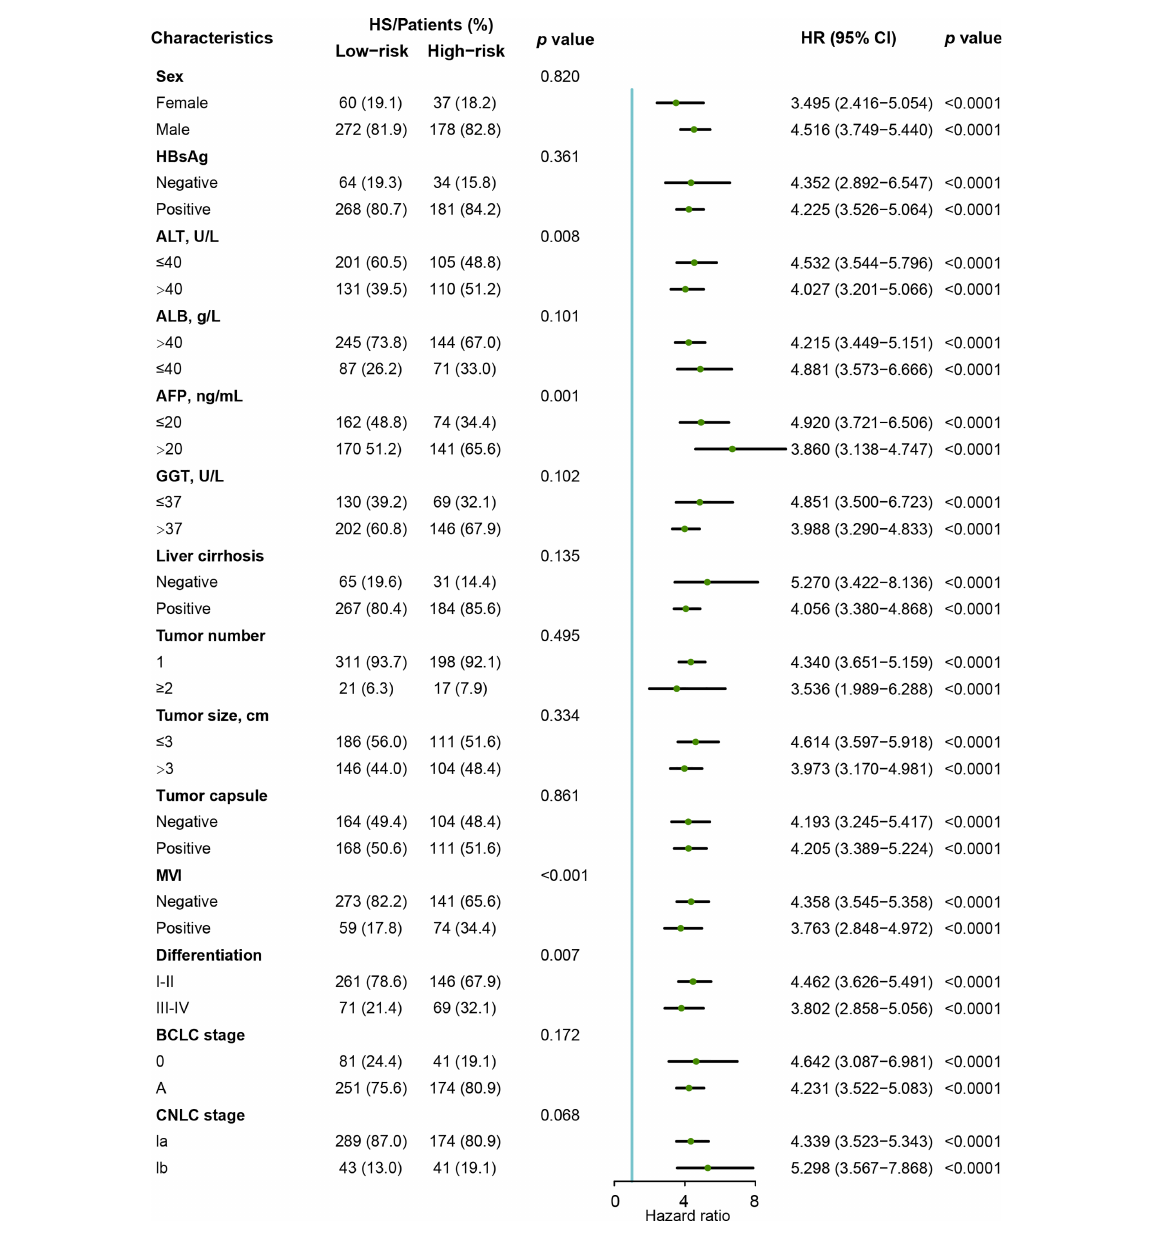
FIGURE 5 Forest plot of recurrence-free survival based on HS in the Zhongshan cohort. HS, histological score; HR, hazard ratio. ; CI, con fi dence interval; AFP, a -fetoprotein; ALT, alanine aminotransferase; ALB, albumin; GGT, g -glutamyl transpeptidase; MVI, micro vascular invasion; CNLC, China Liver Cancer Staging; BCLC, Barcelona Clinic Liver